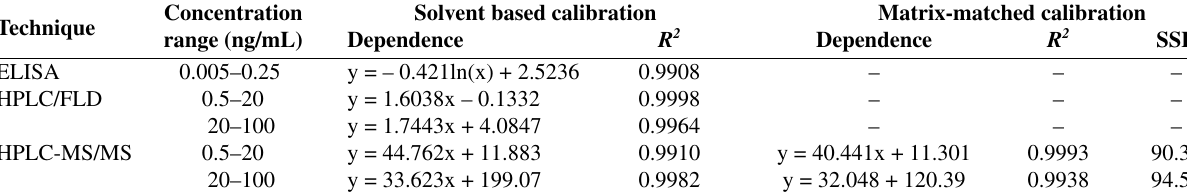
Table 2. Characteristics of the calibration curves